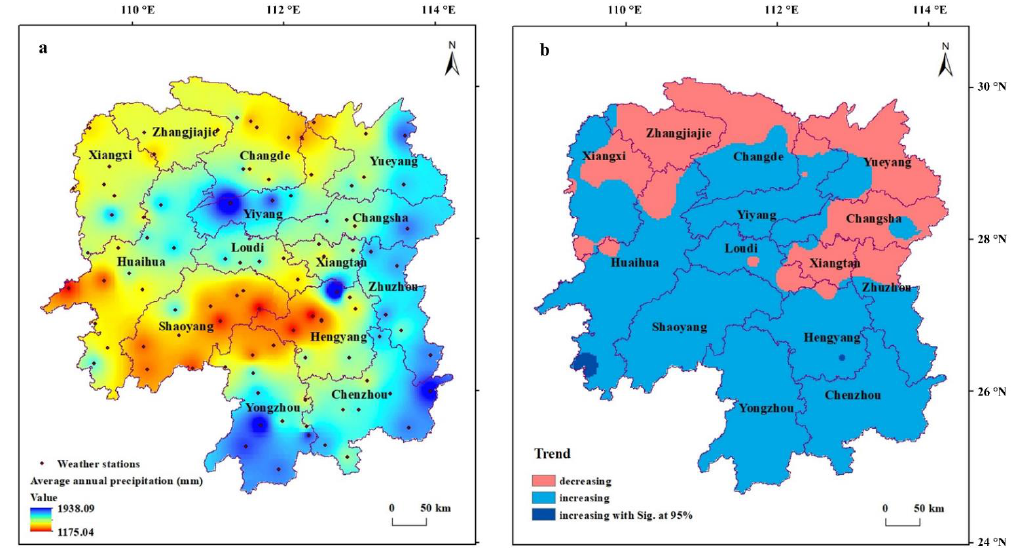
Figure 3. Spatial distribution of average annual precipitation based on data from 2010 to 2019 in Hunan Province ( a ), and the average annual precipitation trend during this period ( b ).